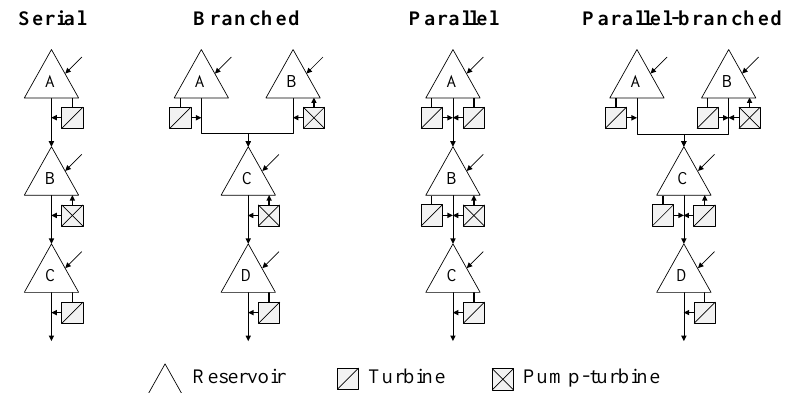
Figure 2. Classification of multistage reservoir systems into serial, branched, parallel, and parallel-branched hydro